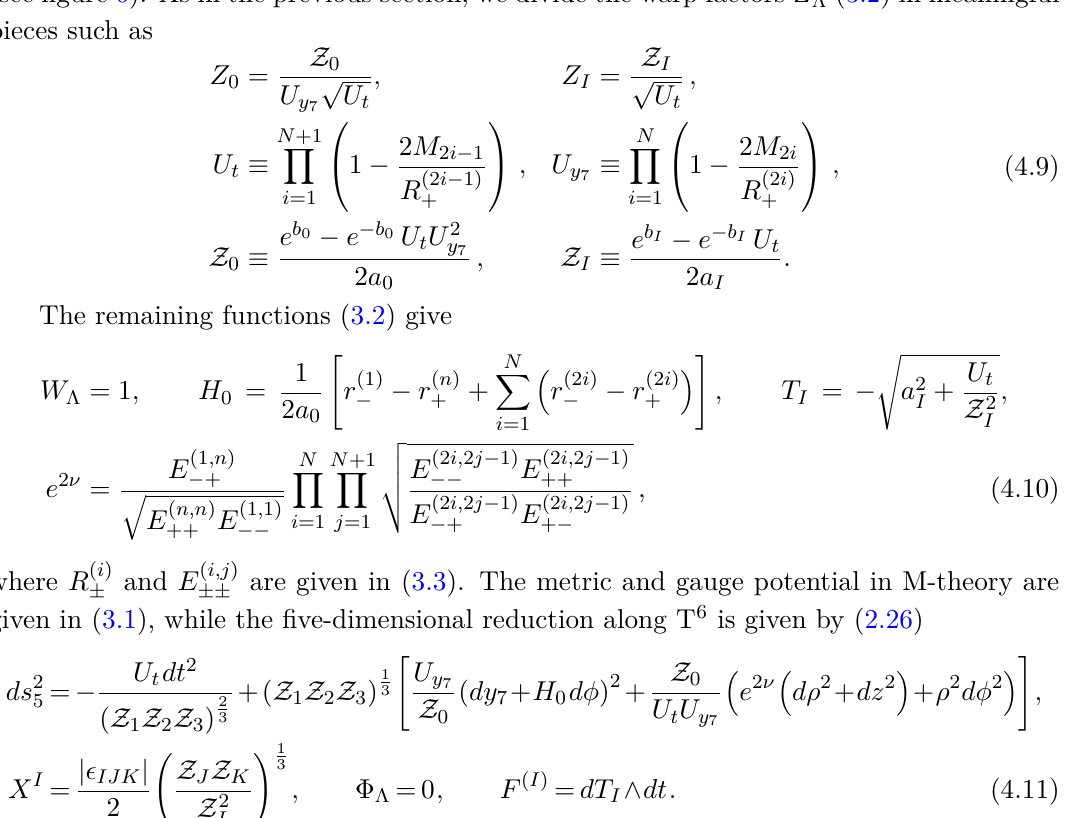
circles on the z 7